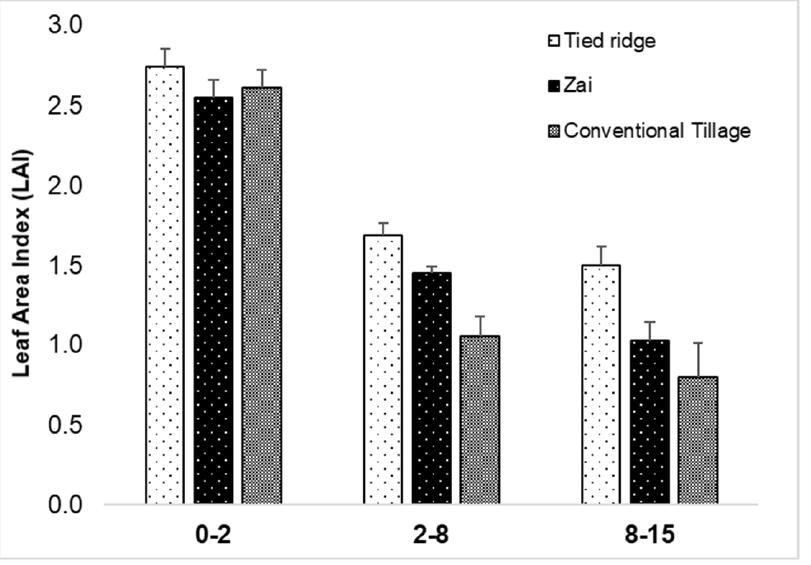
Figure 3. Leaf area index under SWC practices along the slope gradient in the Ruzizi Plain.